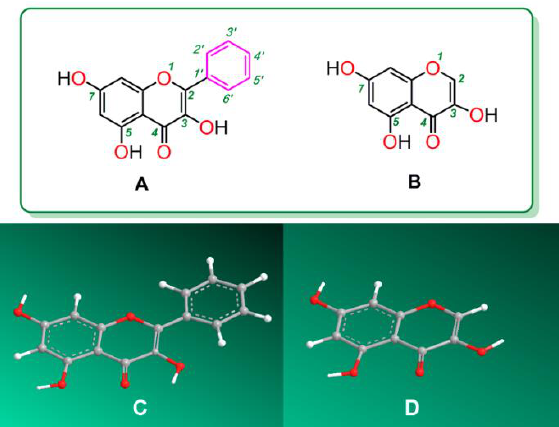
Figure 2. Structural formula and molecular models of galangin and 3,5,7-trihydroxychromone: ( A ), structural formula of galangin; ( B ) , structural formula of 3,5,7-trihydroxychromone; ( C ) , preferential conformation-based molecular model of galangin; and ( D ), preferential conformation-based molecular model of 3,5,7-trihydroxychromone. The molecular models were created using Chem3D Pro 14.0.